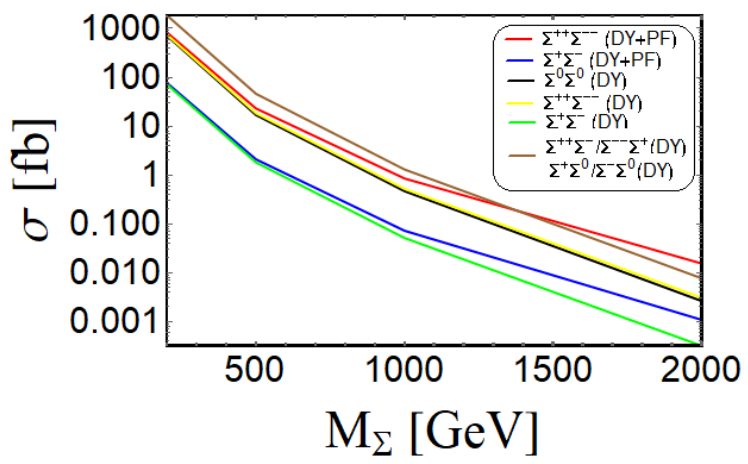
Figure 22 . Pair production cross-section of vector like leptons ((cid:6) ++ ; (cid:6) + ; (cid:6) 0 ) at 13 TeV